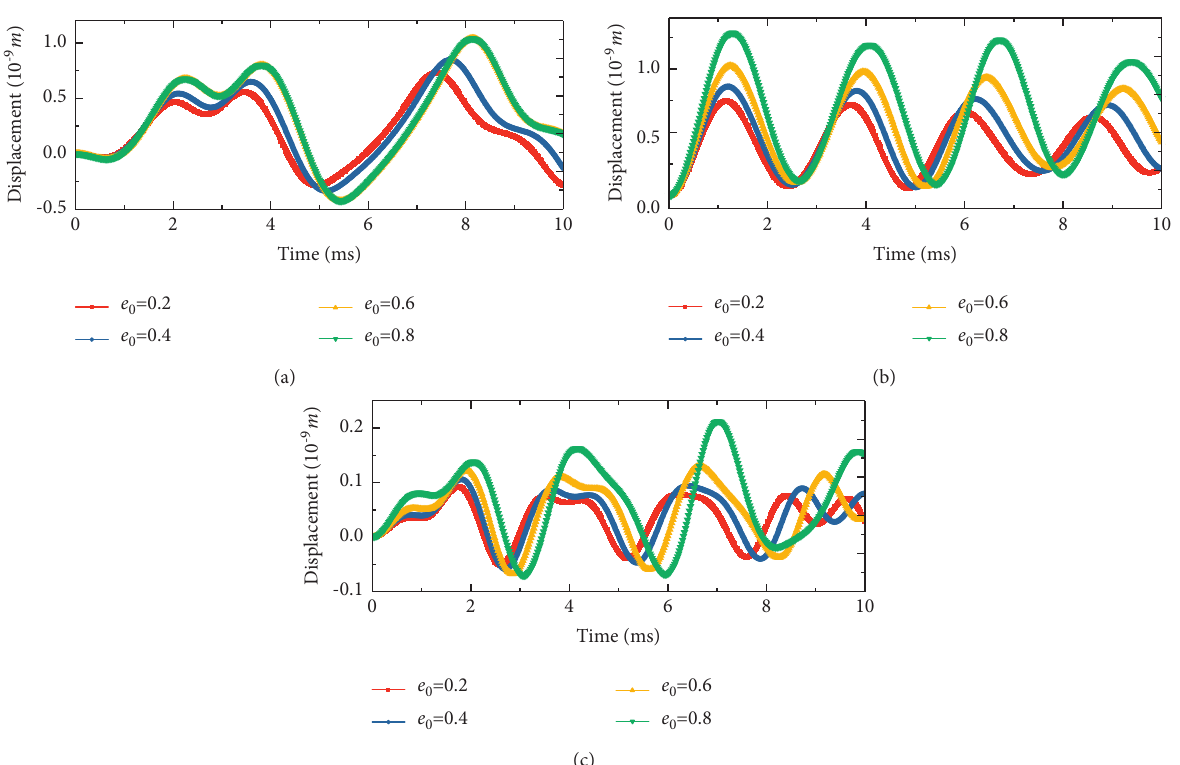
Figure 13: Study on the effect of porous coefficient on the transient response of Sandwich FGP doubly curved structure: (a) Sandwich FGP paraboloidal shell; (b) Sandwich FGP hyperbolic shell; (c) Sandwich FGP elliptical